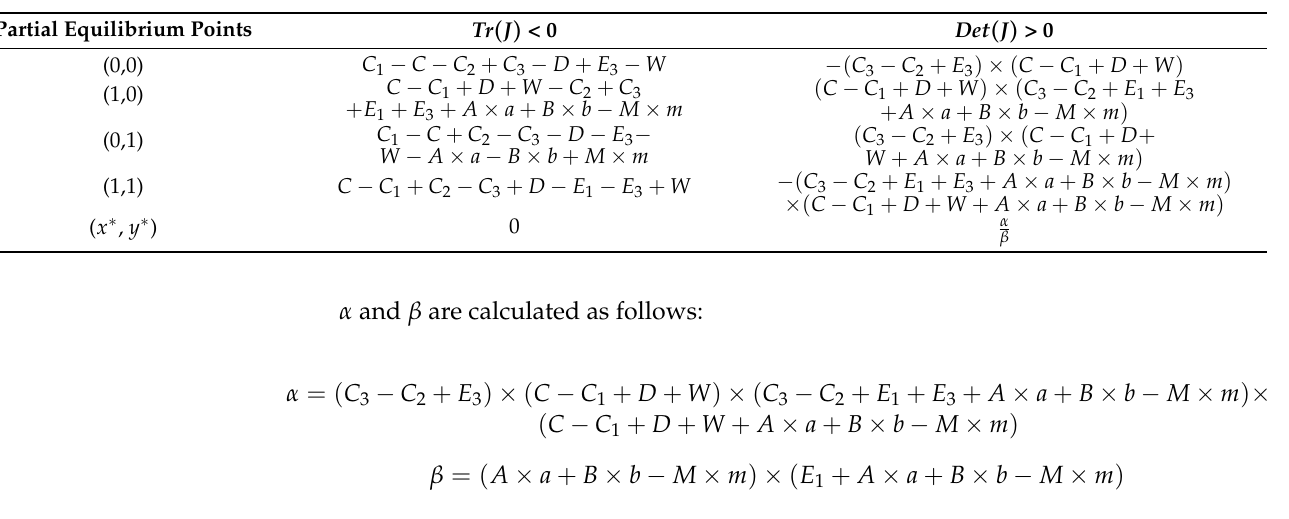
Table 6. Jacobian matrix